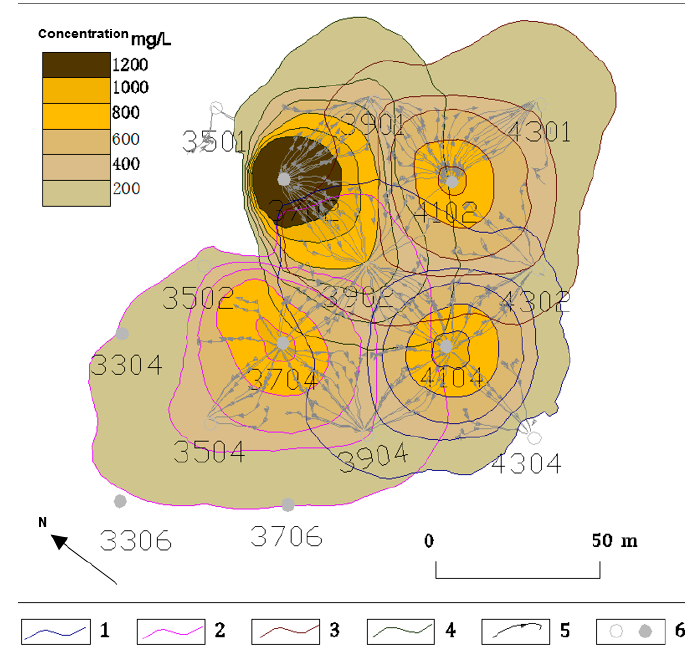
Figure 14. Solute migration distribution of unit 3902 on day 32. (Note: 1—migration range of solute S4104; 2—migration range of solute S3704; 3—migration range of solute S4102; 4—migration range of solute S3702; 5—flow field streamlines of ISL of uranium; 6—pumping and injection wells in the stope).